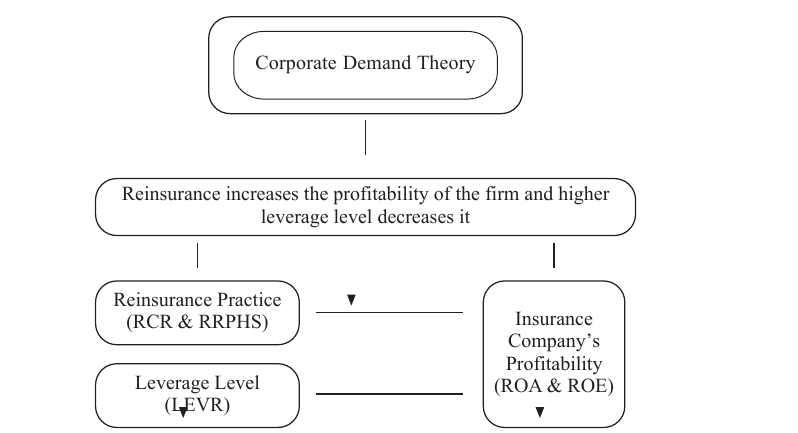
Figure 1: Connecting Figure of Corporate Demand Theory (CDT) and